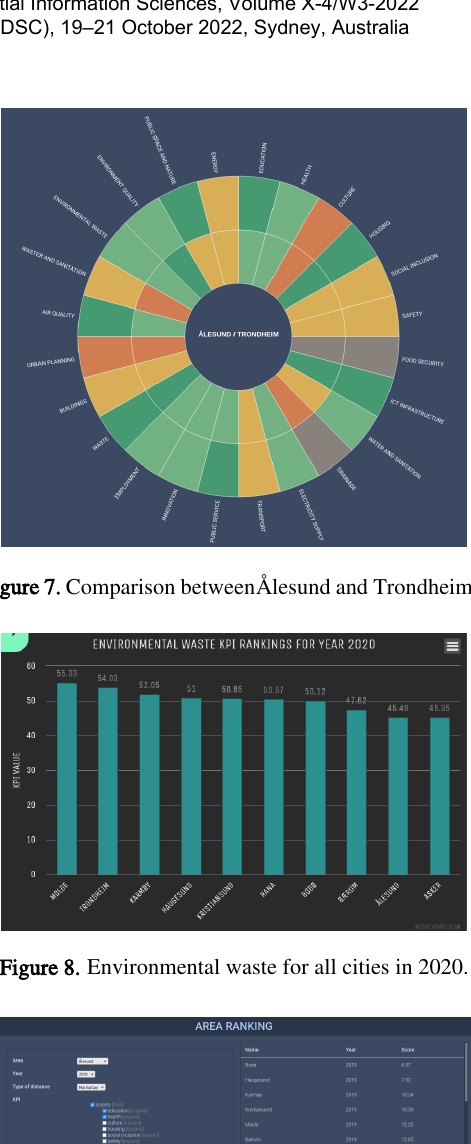
Figure 5. SDG indicators for ˚Alesund, Norway.